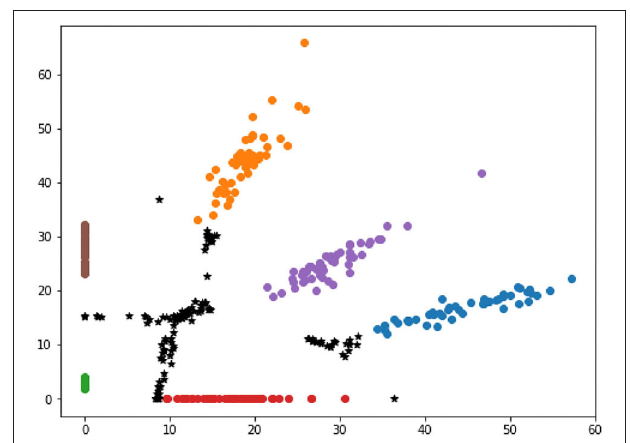
FIGURE 7 | The visualization of high distance-entropy samples.